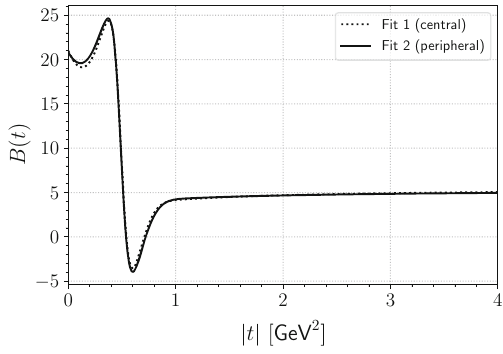
Fig. 9 t -dependence of elastic hadronic diffractive slopes B ( t ) calcu- lated with the help of Eq. (6) and corresponding to Fits 1 and 2 at energy of 8 TeV